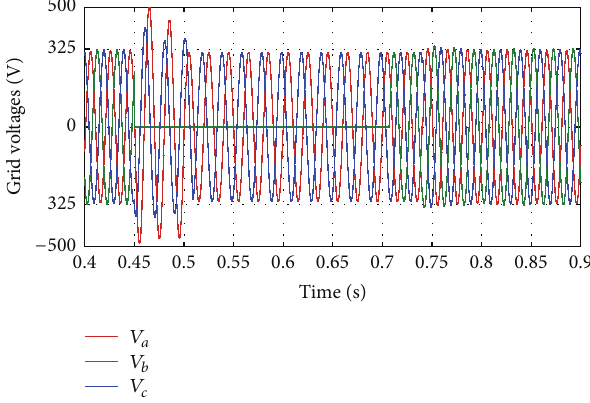
Figure 11: Three-phase grid voltages during disturbance.